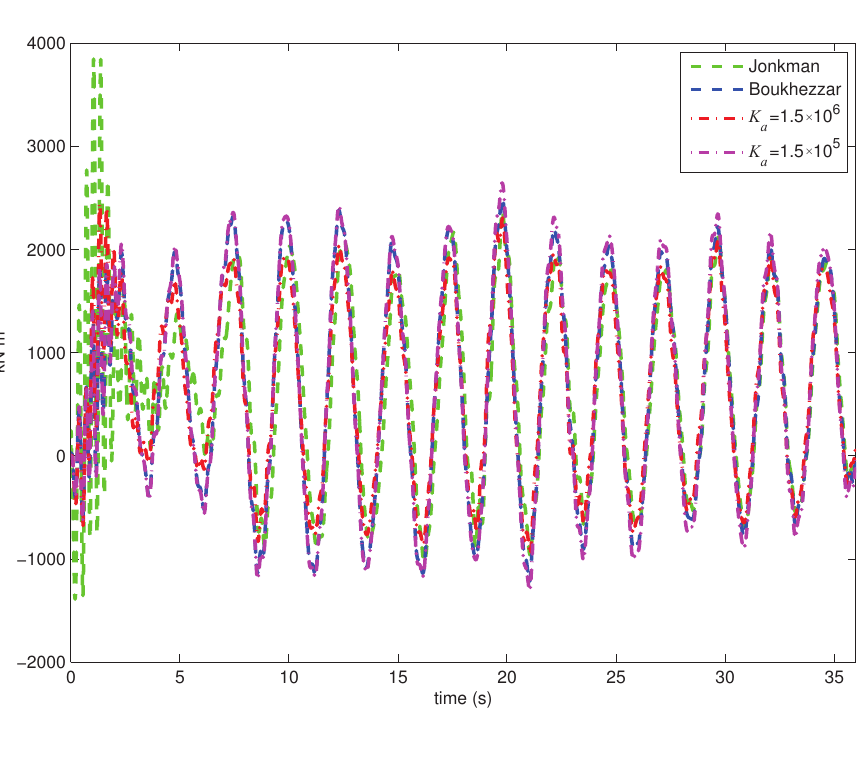
Figure 8. Tower bottom side-to-side